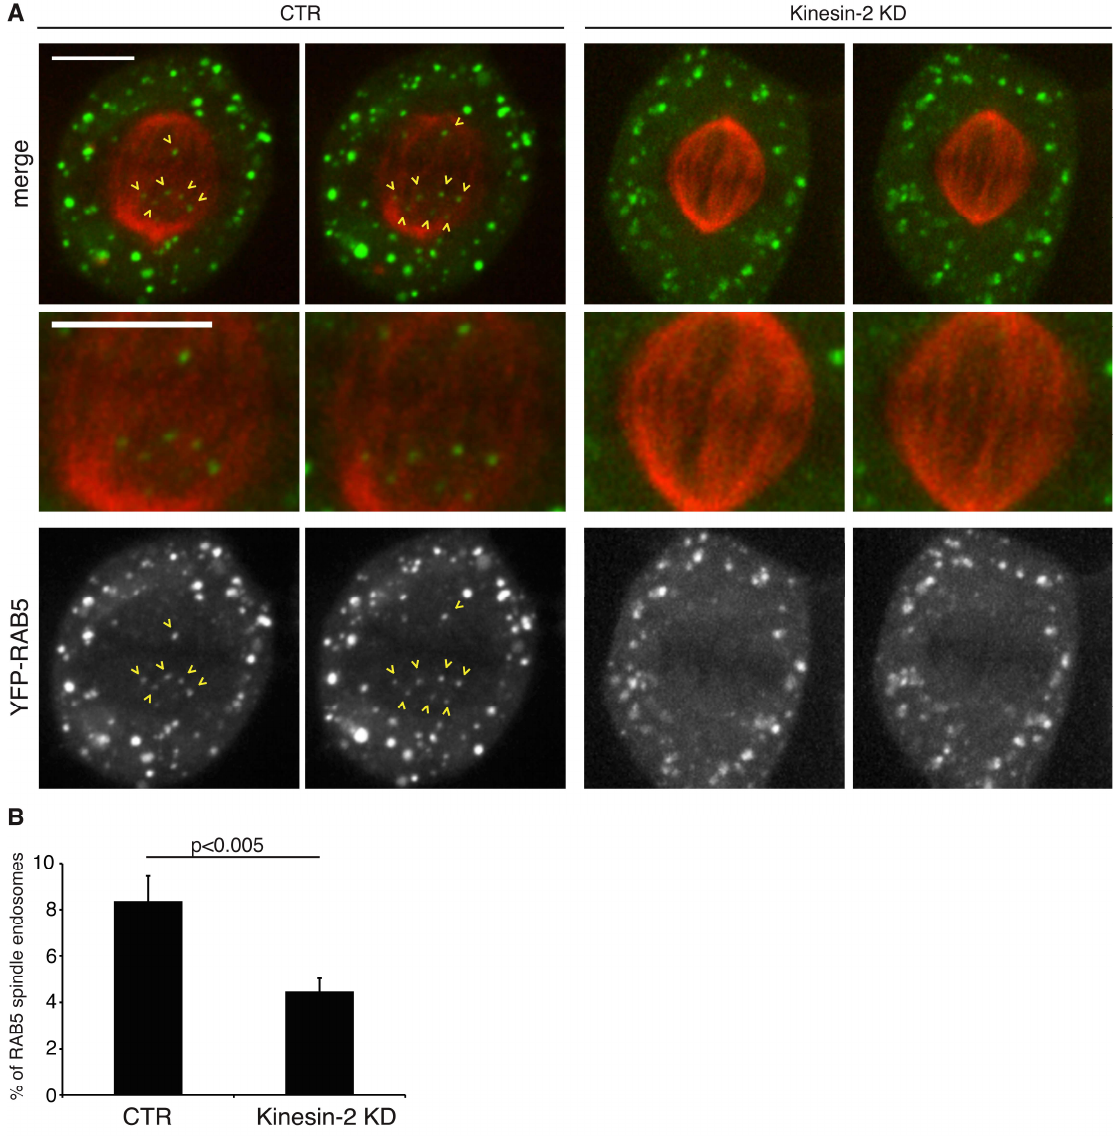
Figure 2. Kinesin-2 silencing reduces the number of RAB5 endosomes that localize to the spindle. ( A ) Two frames have been selected from the movies showing metaphase YFP-RAB5 and RFP-α-tubulin cells, silenced as indicated on top. In the control cell (corresponding to movie M3) frame 40 and frame 79 have been selected; in Kinesin-2 KD (movie M4) frame 45 and 73 are shown. The images are Z-projections of seven slices (corresponding to 3 μm) taken in the equatorial region of the spindle. The intensity of the red channel has been increased exclusively in this panel in the control cell for visualization purposes. Arrows indicate the RAB5 endosomes located within the spindle in the control cell. No vesicles can be found on the spindle in the Kinesin-2 KD cell. This region of the spindle is also magnified in the panels below. Scale bar here and in the following figures is 10 μm. ( B ) Bar graph representing the percentage of RAB5 positive vesicles at the spindle of cells silenced with control oligo (CTR) or with KIF3A and KIF3B oligos (Kinesin-2 KD). At least 30 movies per condition from three independent experiments were analyzed (mean ± SEM).